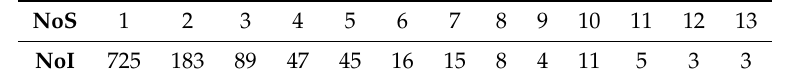
Table 3. The detailed information of SSDD.